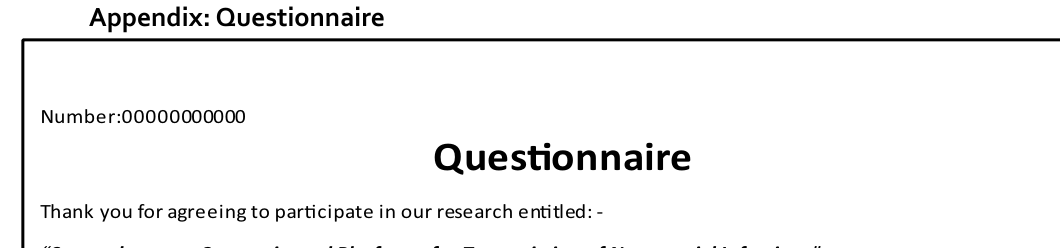
Table 2. Factors associated with mobile phone hygiene and decontamination